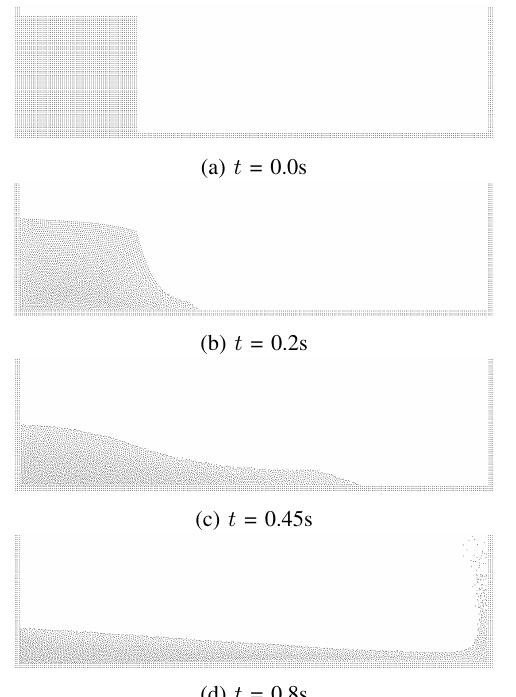
Fig. 8: CMPS-HS-HL-ECS method visual results for L = H = 0 . 6 m